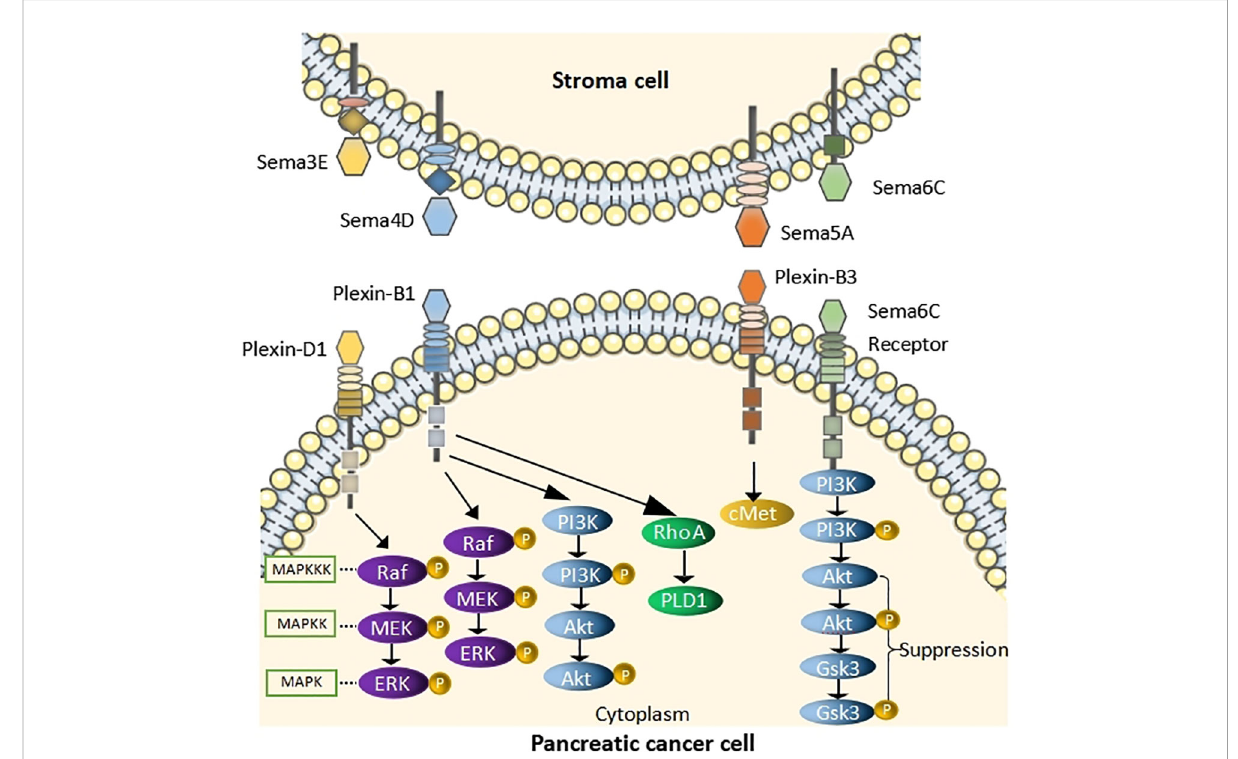
FIGURE 1 Schematic of pathway depicting the role of Semas in PC Sema3E binds to Plexin-D1and induces cell proliferation by acting through the MAPK/ ERK pathway. Sema4D binds to Plexin-B1, activates RhoA, causes the phosphorylation of MAPK and Akt. Sema5A binding to Plexin-B3 activates cMet signaling to enhance migration of PC cells. Sema6C binds to its receptor and suppress AKT/GSK3 signaling